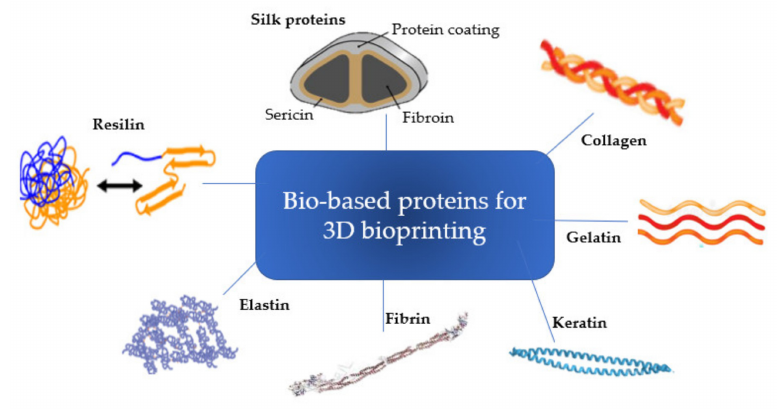
Figure 2. Most used proteins for biomedical